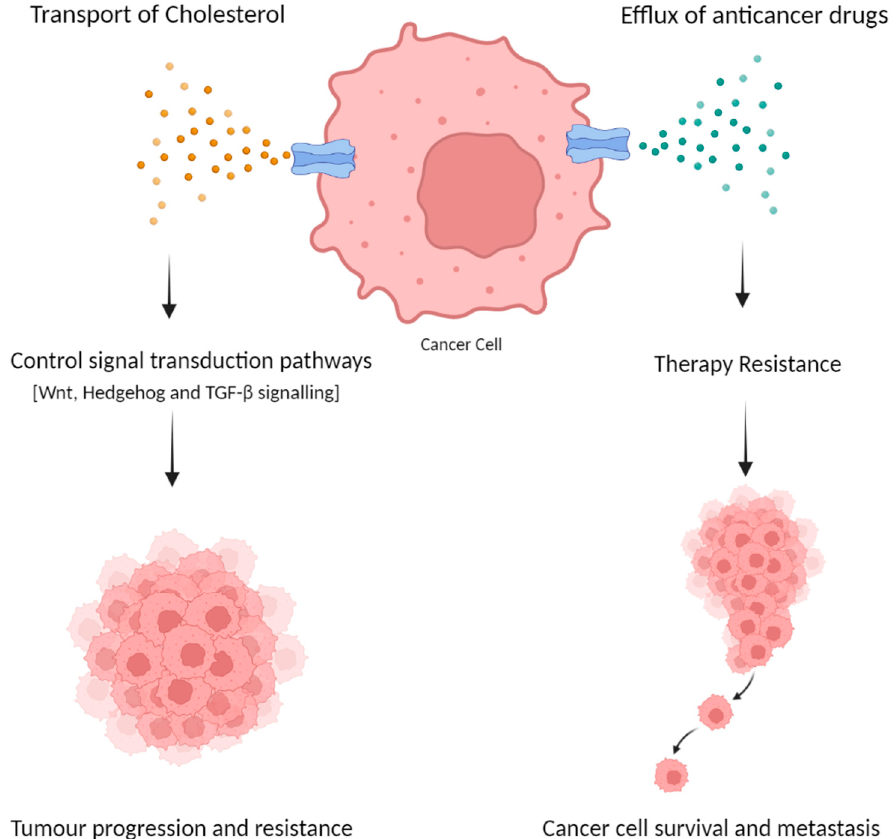
Figure 2. Proposed involvement of ABCA subfamily transporters in colorectal cancer progression and resistance. ABCA members can be overexpressed in cancer cells. They are mainly known for cholesterol transport, which can control various signalling pathways related to EMT and promote cancer progression and resistance. Additionally, ABCA transporters can promote drug efflux from the cells causing therapy resistance and leading to cancer cell survival. Figure generated by BioRen- der.